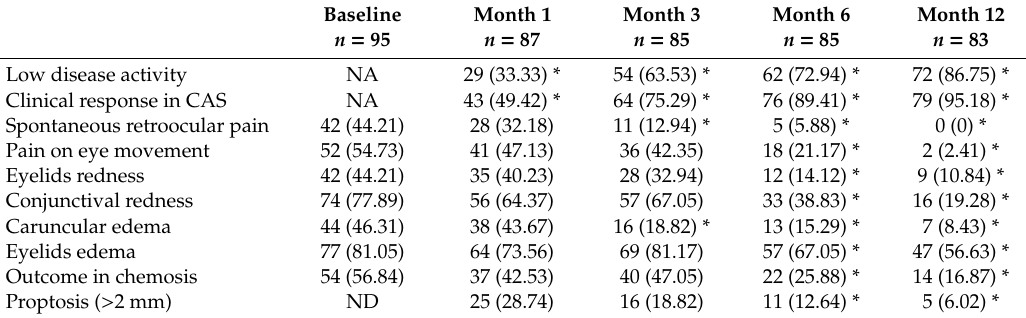
Figure 2. Patient included in this series with severe and refractory Graves’ orbitopathy at ( A ) Tocilizumab onset and ( B ) after five months of Tocilizumab therapy. (Courtesy of Dr. Torre-Salaberri, Basurto Hospital, Bilbao). Table 2. Evolution of secondary ocular outcomes in patients with Graves’ orbitopathy after Tocilizumab onset.